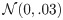
One thousand opinion agents, 2 topics, 100000 iterations, d = .26, noise from N(0,.03), μ = .4—(a) Independent evolution. Final state, (b) Evolution in tandem. Final state, (c) Independent evolution. Time distribution, (d) Evolution in tandem. Time distribution.